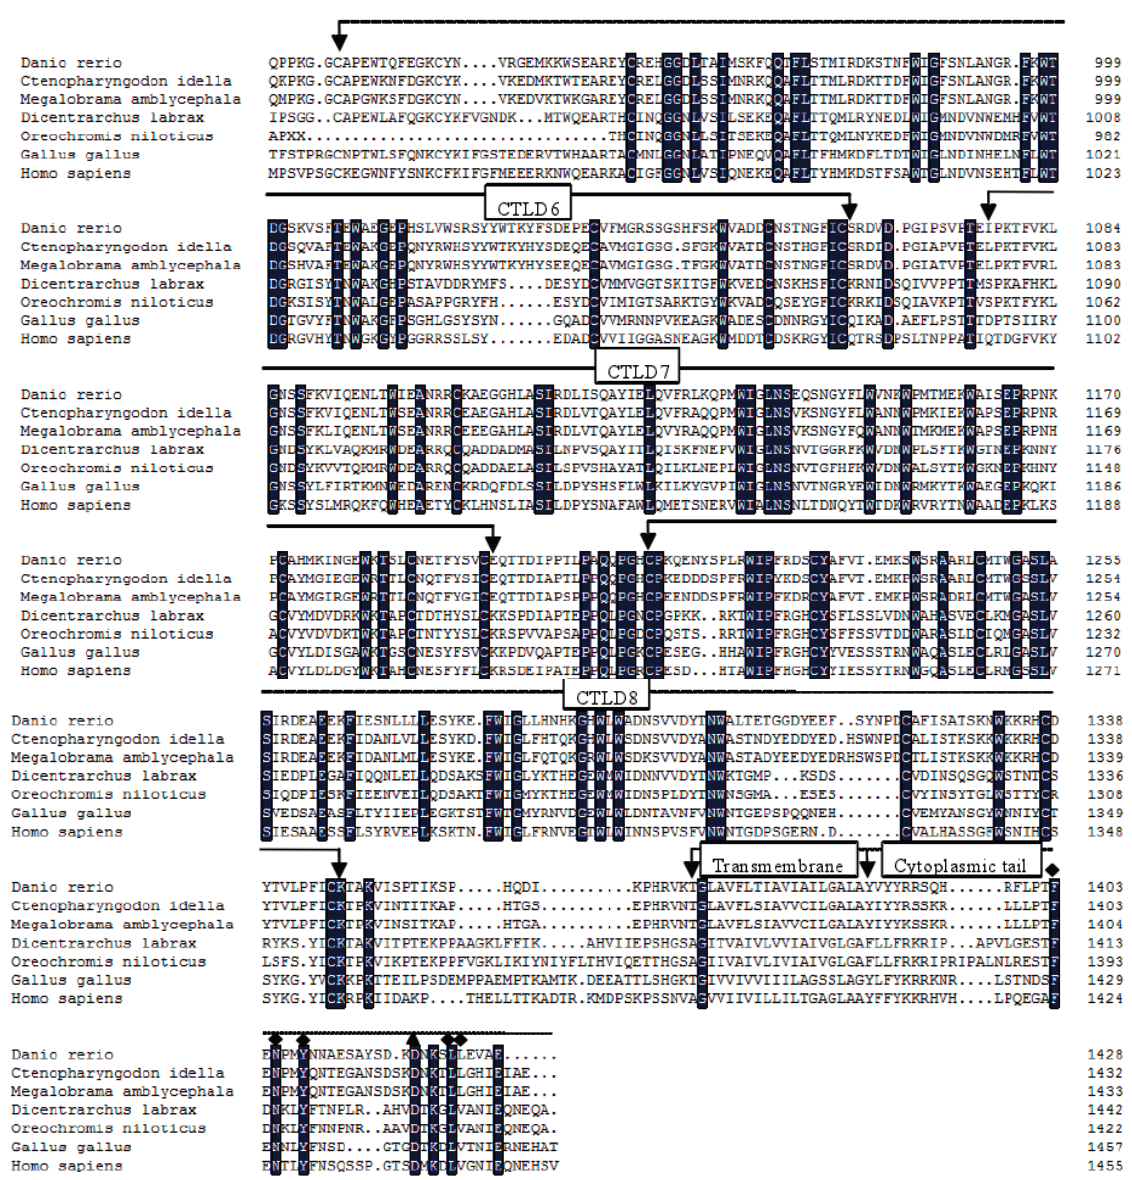
Figure 1. Multiple alignment of mannose receptor (MRs) using the DNAMAN program. The identical residues among all the MRs were in black. The absent amino acids in the alignment were indicated by dots (.). Conserved cysteine residues were marked with ● , aromatic residues F (Phe 167 ) and W (Trp 188 ) were marked with ★ . Two conserved sites of carbohydrate recognition domain (CRD), “EPN” and “WND” were boxed. Ca 2+ binding site 1 was marked with ■ , Ca 2+ binding site 2 was marked with ▼ . Two potential endocytosis motifs, “F-N-Y” and a dihydrophobic motif “LL” were marked with ♦ . The conserved acidic residue “D” lying-4 to the dihydrophobic modif was marked with ▲ . The GenBank accession numbers of the MRs were as follows: Danio rerio (KP172154); Ctenopharyngodon idella (KF569903.1); Megalobrama amblycephala (KC495437.1); Dicentrarchus labrax (CBN82067.1); Oreochromis niloticus (XP_003439398.1); Gallus gallus (XP_004939311.1); Homo sapiens